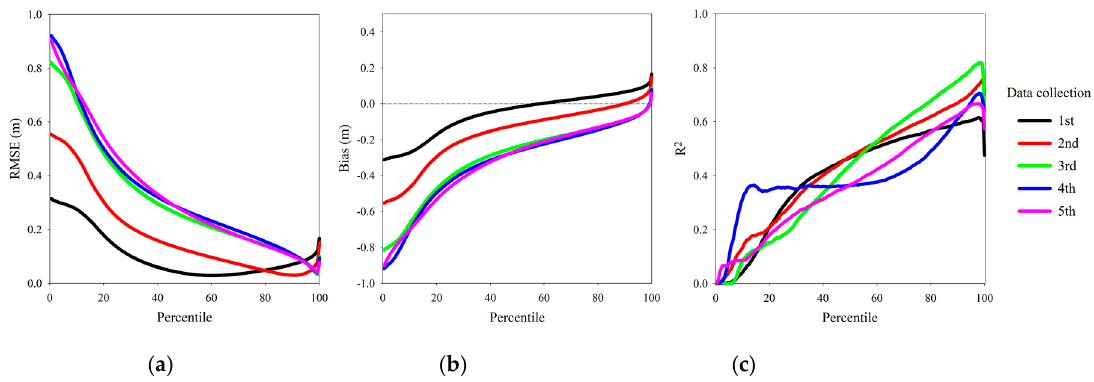
Figure 8. Statistical results of heights extracted at different percentiles from processed LiDAR point clouds over five data collection campaigns: ( a ) RMSE; ( b ) bias; ( c ) R 2 . For a point cloud, low percentiles of the Z value represent the height of ground, and high percentiles represent the height of vegetation above ground. Since the height of a wheat plot was